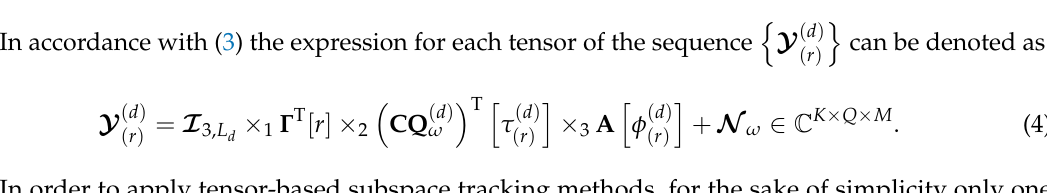
Figure 1. Observed epochs being concatenated into the dimension K of the previously acquired